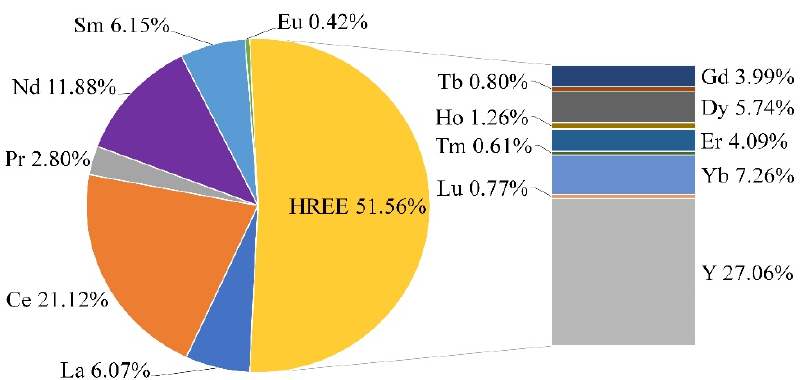
Figure 10. Distribution of individual rare earth elements in Zr-REE-bearing concentrate.